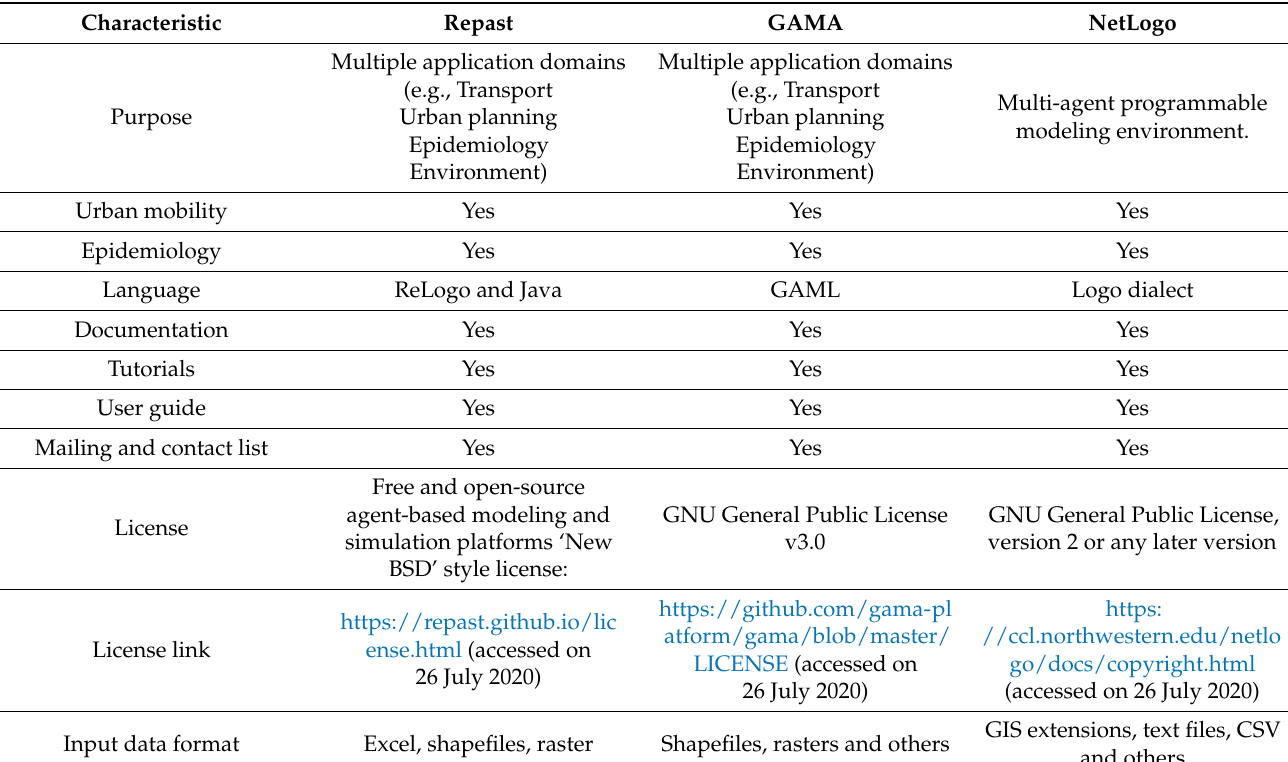
Table A1. Open source ABM